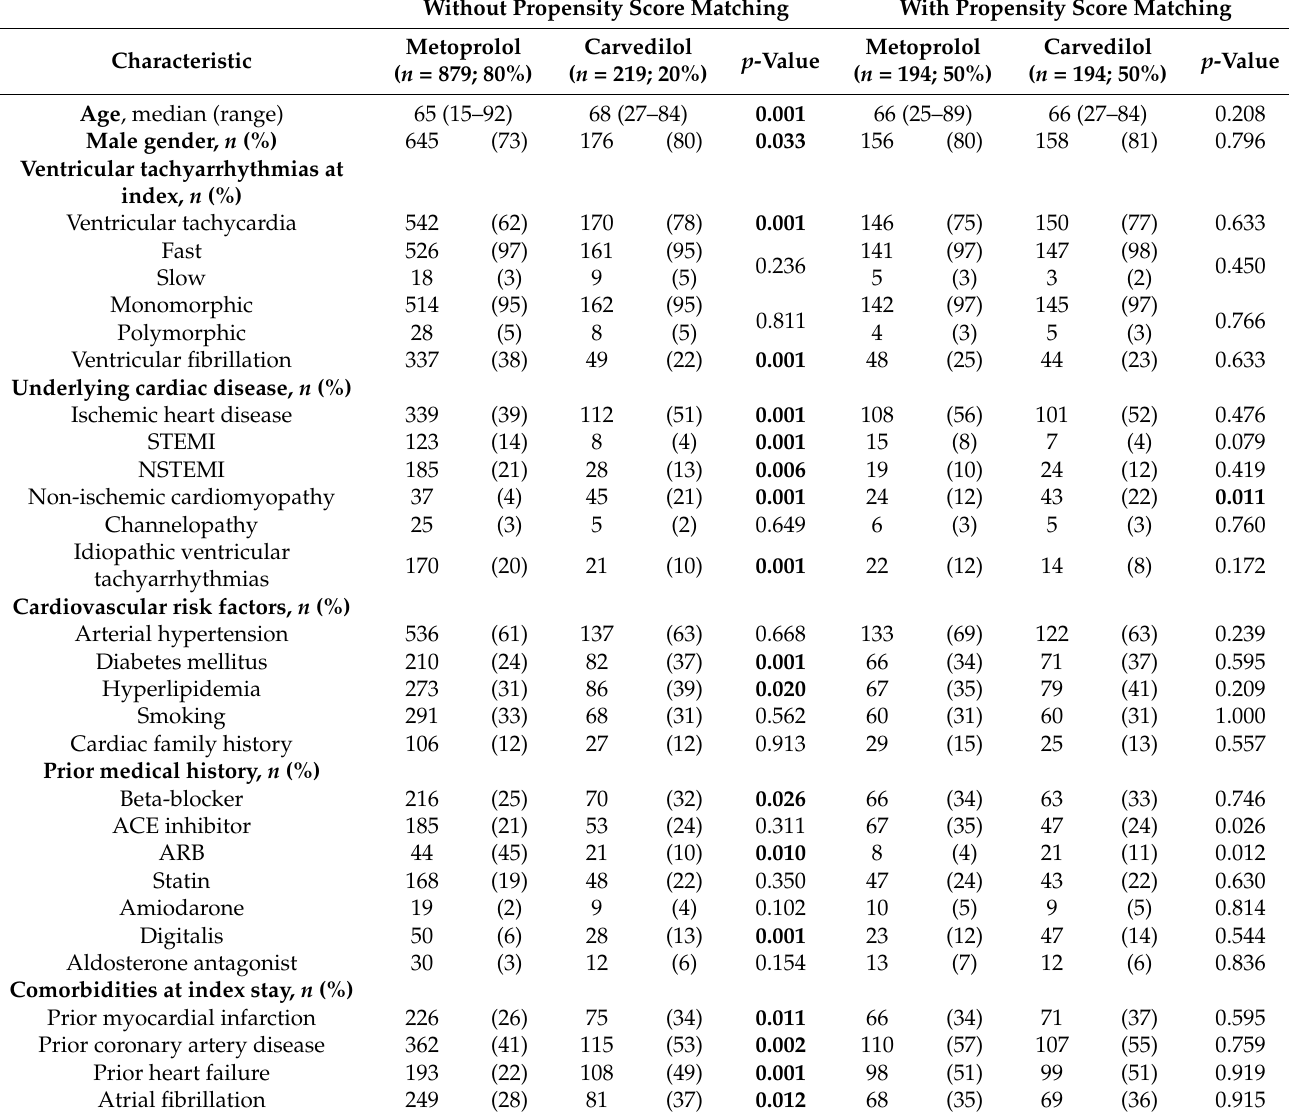
Table 1. Baseline